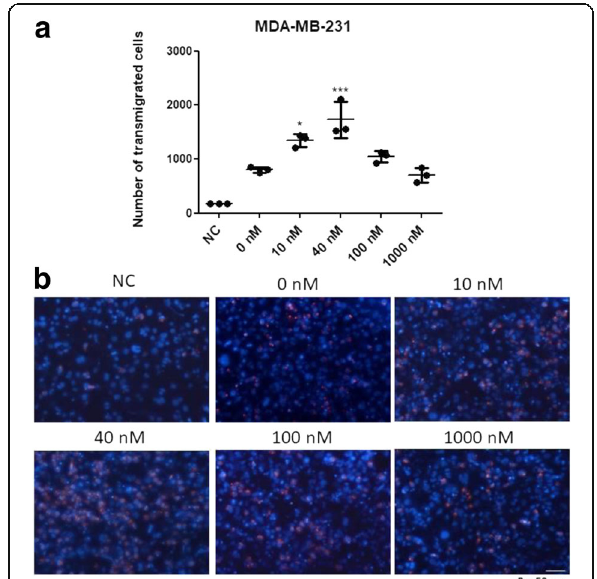
Fig. 2 ALT-C stimulates the transmigration of MDA-MB-231 cells through a monolayer of HMEC-1 cells. a MDA-MB-231 cells were plated in wells containing HMEC-1 cells, and 5% of fetal bovine serum (FBS) was used as a chemoattractant in the lower chamber. Tumor cells were first stained with PKH26 Red Fluorescent Cell Linker and after 16 h of transmigration assay the cells were fixed, stained with DAPI and counted (an average of eight fields from each treatment). Negative control means the assay in the absence of FBS in the lower chamber. The assay was performed in triplicate with two independent assays ( n = 2). The results were compared using ANOVA followed by Tukey ’ s test (* p < 0.05, and *** p < 0.001). b Representative images of transmigrated cells of each treatment. Bar represents 50 μ